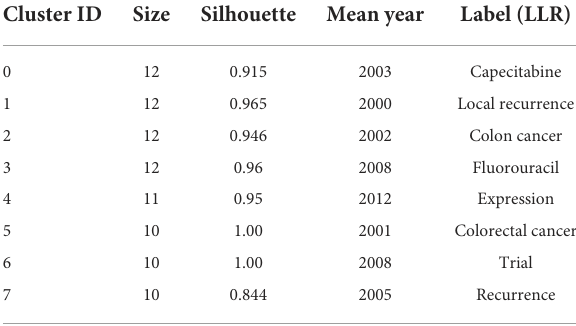
TABLE 4 Main clusters of